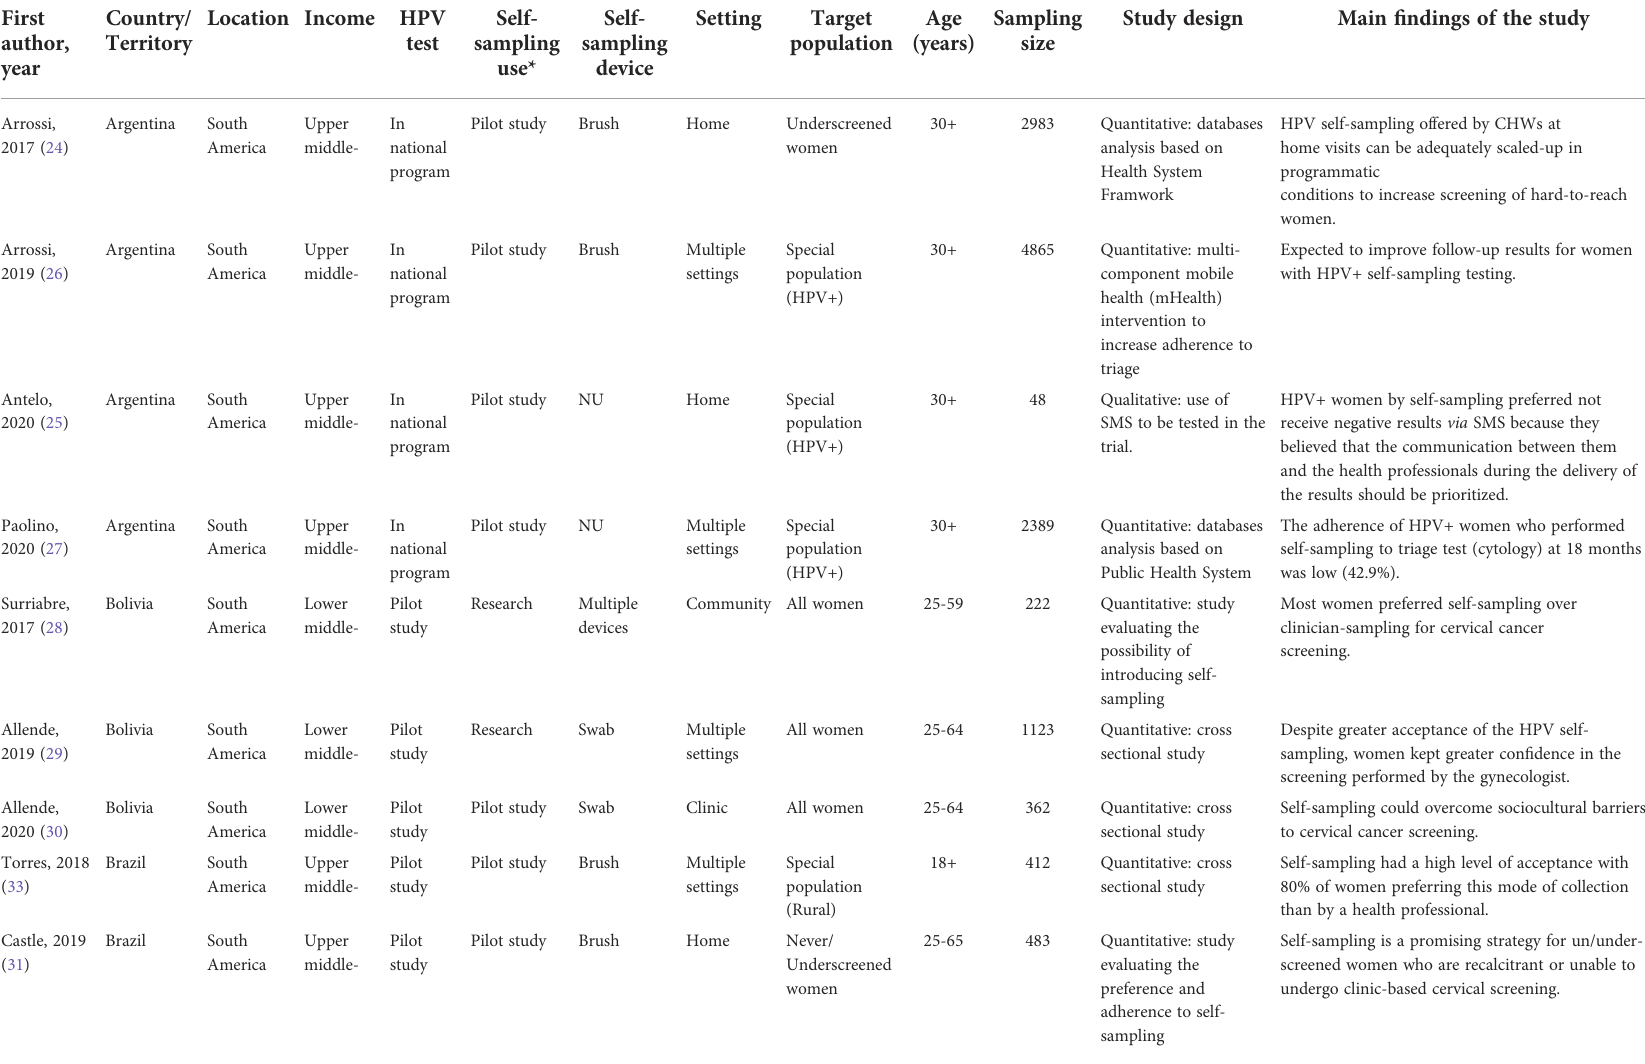
TABLE 2 Characteristics of included